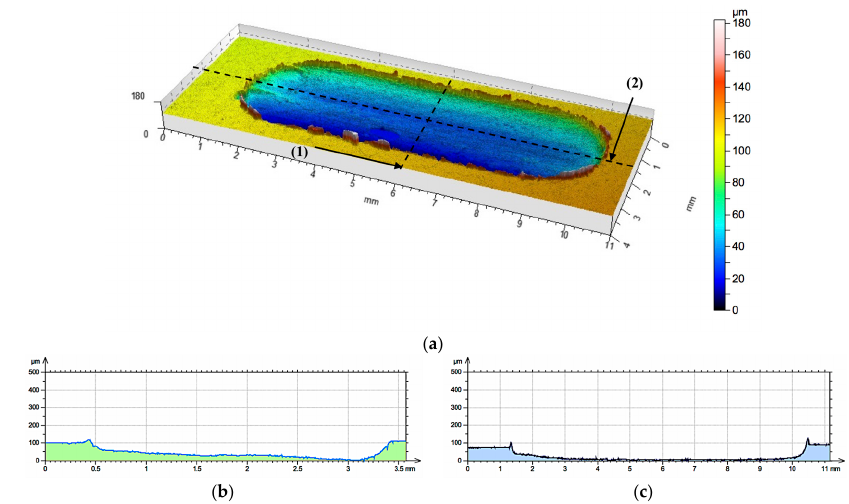
Figure 10. Surface geometry of the AlSi12 unreinforced area after working with cast iron pin: ( a ) view of the wear track; ( b ) roughness distribution across to the friction direction on line (1); ( c ) roughness distribution along the friction direction on line (2).